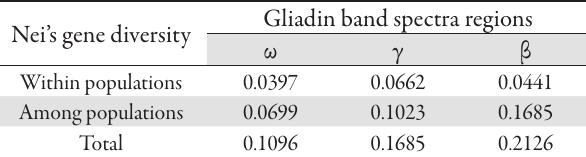
Tab. 3. Among and within population genetic diversity of